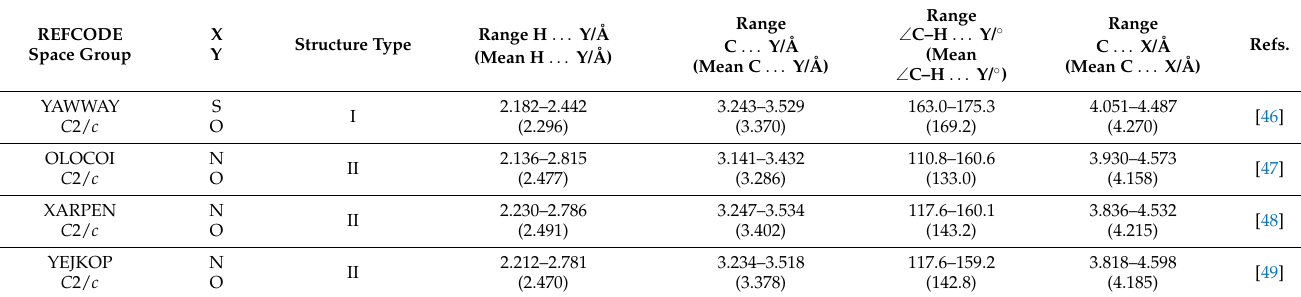
Table 1. Structure Type I and II complexes with [XY 3 ] m – anions.